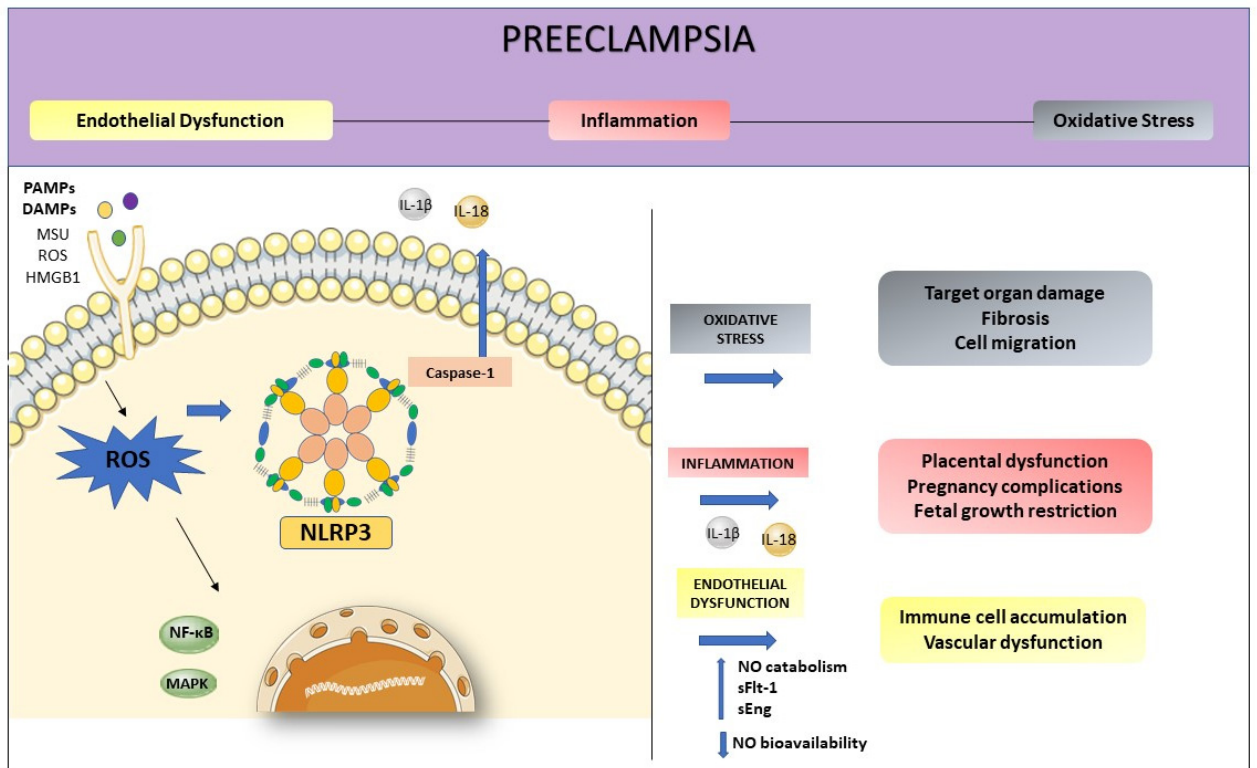
Figure 3. Preeclampsia is characterized by intense oxidative stress, inflammation, and endothelial dysfunction. The activation of NLRP3 may start with the production of ROS. Inflammasome activation is responsible for the release of inflammatory agents during the immune response, such as IL-1 β and IL-18. High levels of ROS increase NO catabolism and decrease NO bioavailability as well as increasing factors such as sFlt-1 and sEng. This process enhanced inflammation-related genes expression, contributing to endothelial dysfunction.